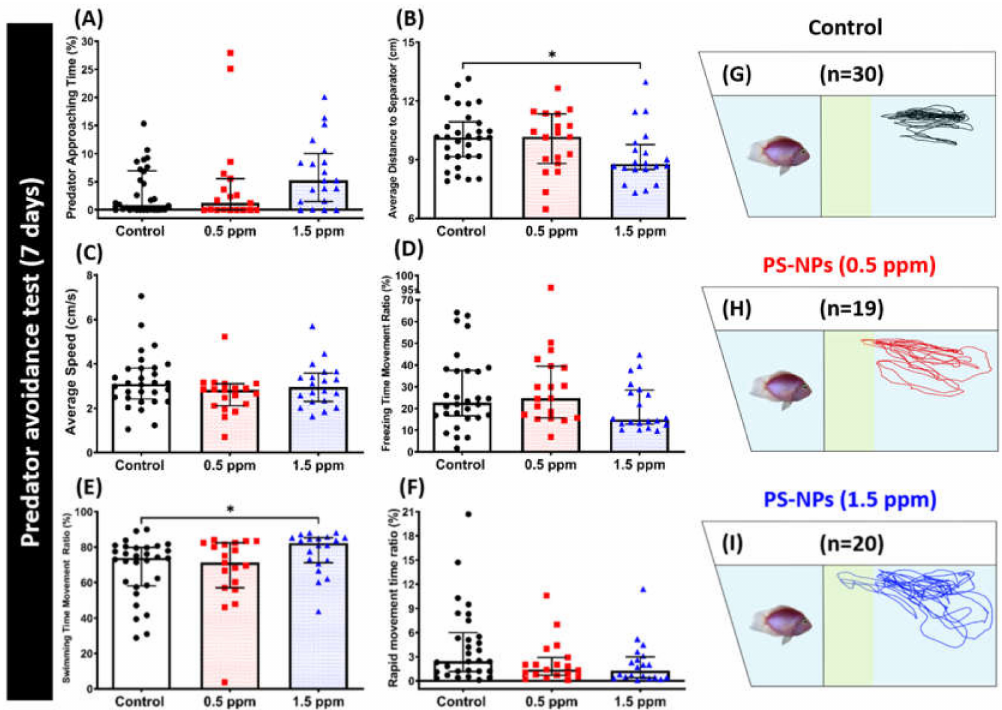
Figure 4. Predator avoidance behavior endpoints comparisons between control and polystyrene nanoplastics (PS-NPs)-exposed zebrafish groups after a ~7-day exposure. ( A ) Predator approaching time percentage, ( B ) average distance to the separator, ( C ) average speed, ( D ) freezing time movement ratio, ( E ) swimming time movement ratio, and ( F ) rapid movement time ratio were analyzed. The 1 min. locomotiontrajectoriesforthecontrol, 0.5and1.5ppmPS-NPsexposedfishinthepredatoravoidancetest were presented in G to I , respectively, with the yellow-colored zone as the predator approaching